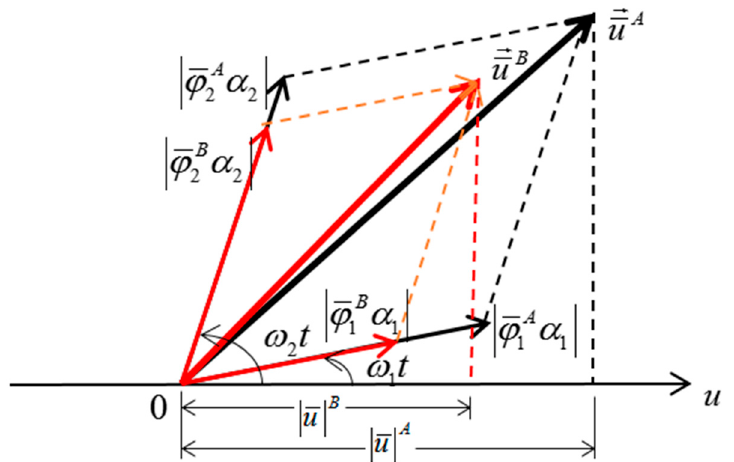
Figure 1. The diagram of the synthesis motion law. As per the trigonometric relationship of relatively synthetic motion, the amplitudes of the relatively synthetic motion of group A and group B can be obtained as Equations (14) and (15), respectively.